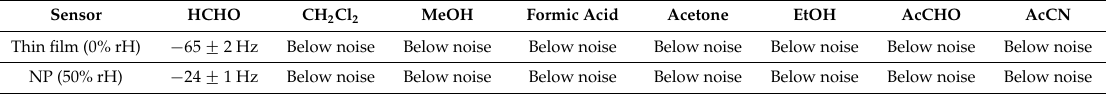
Figure 7. Selectivity patterns of MIP thin films and MIP NP layers showing relative signals.